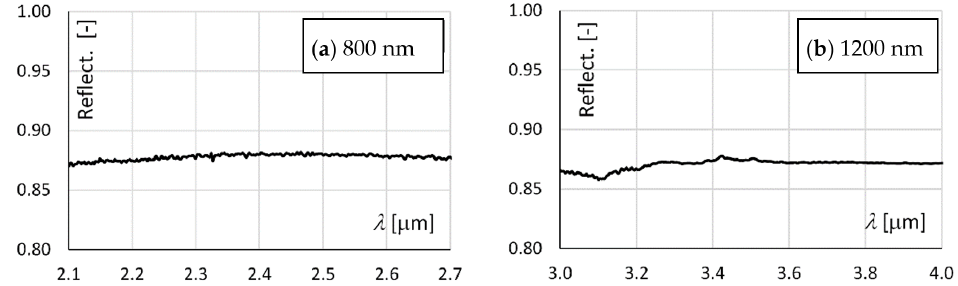
Figure 5. Measured reflectance of shorter dipole array structures with lengths ( a ) 800 nm and ( b ) 1200 nm.